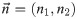
Sampler’s strategies n→=(n1,n2) vs Min(z1*,z2*).